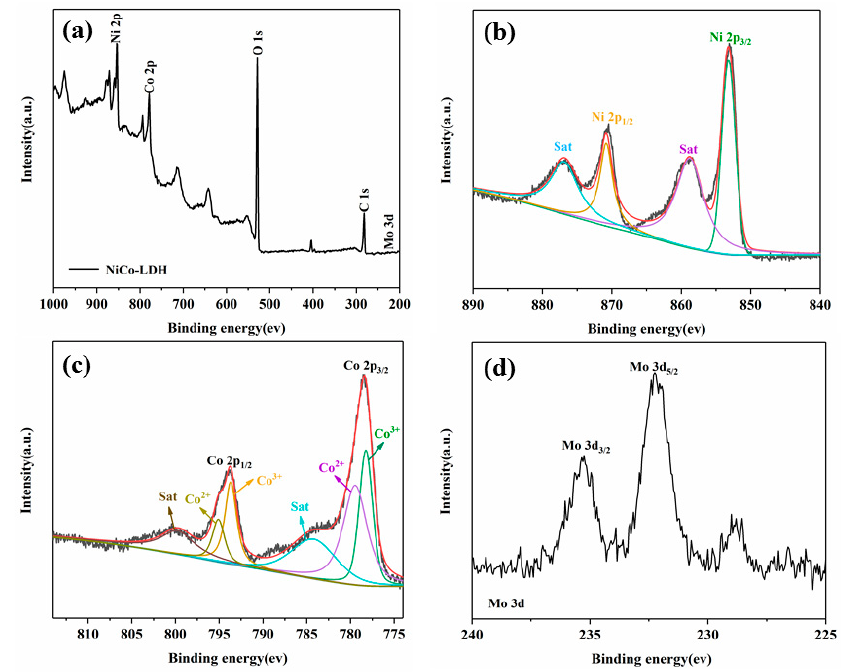
Figure 5. XPS survey spectrum of NiCo-LDH/MoS 2 ( a ), high-resolution XPS spectra of Ni 2p, Co 2p and Mo 3d for NiCo-LDH/MoS 2 ( b – d